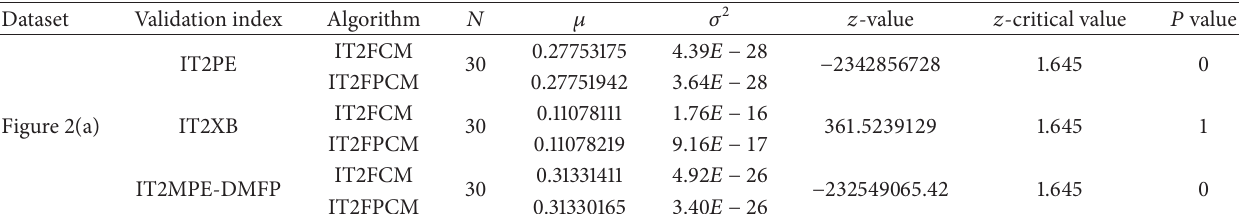
Table 28: Hypothesis test for IT2PE, IT2XB, and IT2MPE-DMFP indices of validation for Figure 2(a) clustering.